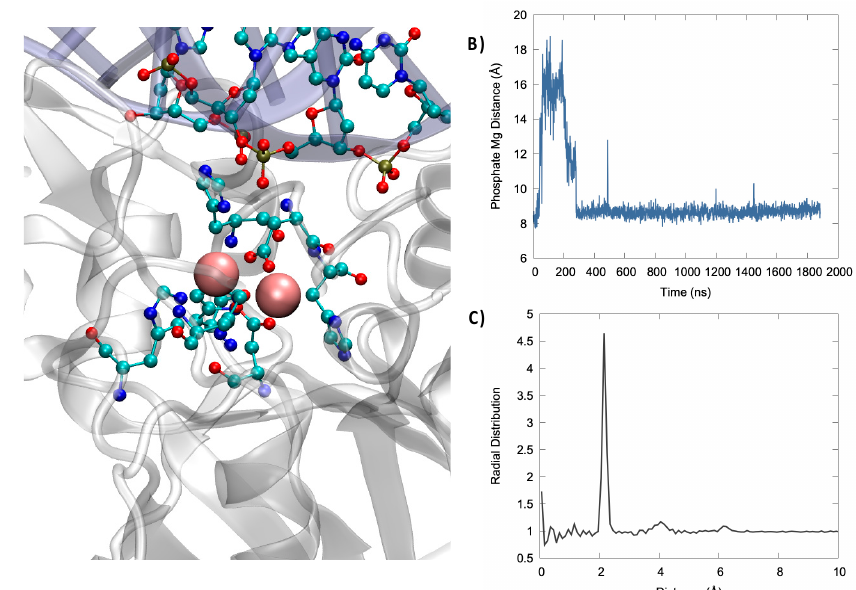
Figure 3. ( A ) Representative snapshot highlighting the catalytic active site organization. (Mg 2+ ) 2 is represented in van der Walls, while the protein amino acids complexing the bimetallic cluster and closest nucleic acid residues are shown in ball and sticks. ( B ) Time series of the evolution of the distance between the phosphate OP atom and the closest Mg 2+ ion. ( C ) Radial distribution function for the distance between Mg 2+ and water oxygen atoms.